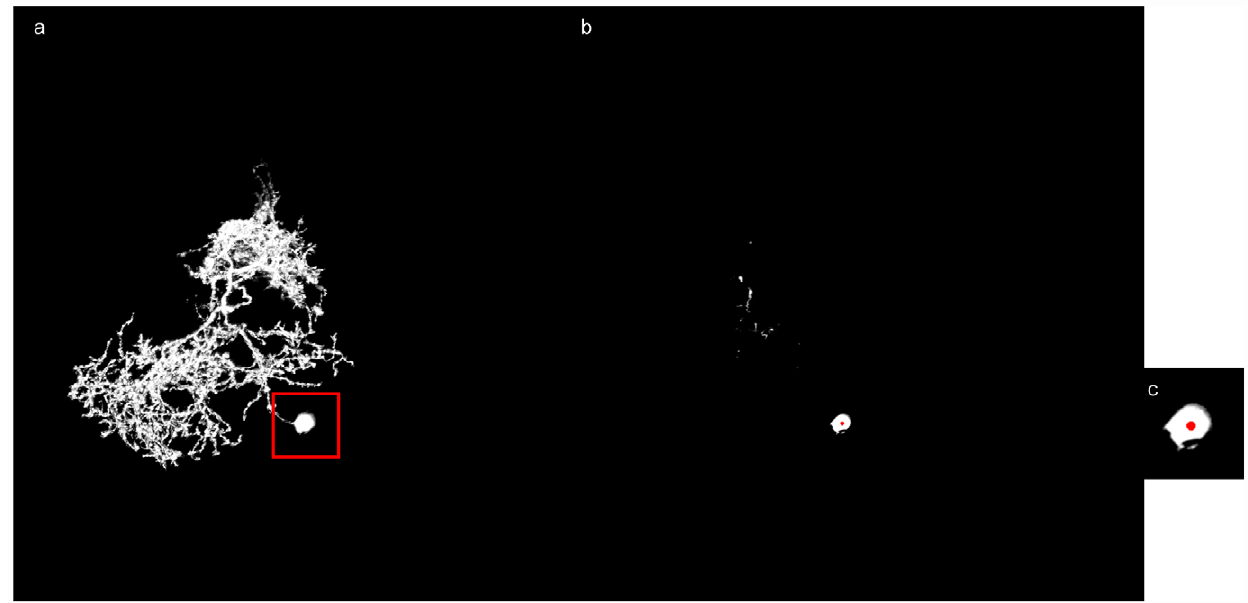
Figure 10. An example of the soma detection. (a) The MIP image of the original image stack. (b) Red dot indicates the center of the soma calculated by the soma detection procedure. (c) A close view of the detected soma position.